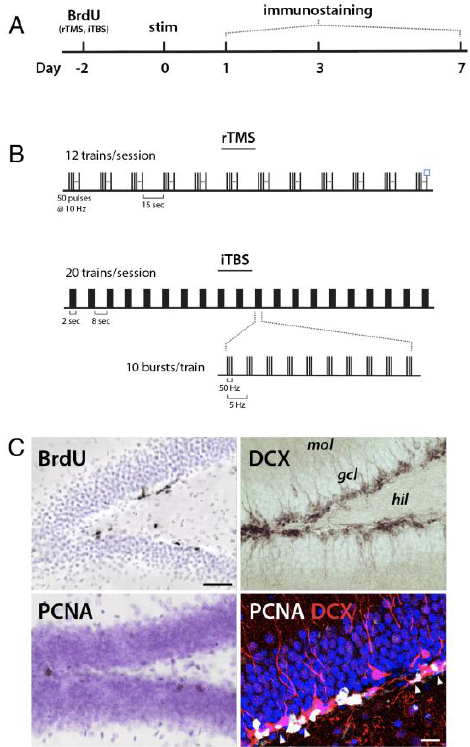
Figure 1. Experimental design. ( A ) Timeline of the experiment. Mice were injected with BrdU (rTMS and iTBS animals) to birthdate neurons born 2 days prior to stimulation. On day 0 mice received a single session of sham stimulation, ECS, rTMS or iTBS. Separate groups of animals were euthanized 1, 3, or 7 days after stimulation for histological analyses of neurogenic markers. ( B ) rTMS and iTBS stimulation paradigms. The smallest bar represents a single pulse at 115% motor threshold. ( C ) Representative brightfield images of BrdU, PCNA, and DCX immunostaining (scale bar, 50 µ m) and confocal image of PCNA + DCX immunostaining with DAPI counterstain (scale bar, 20 µ m). Arrowheads indicate PCNA + DCX + double positive